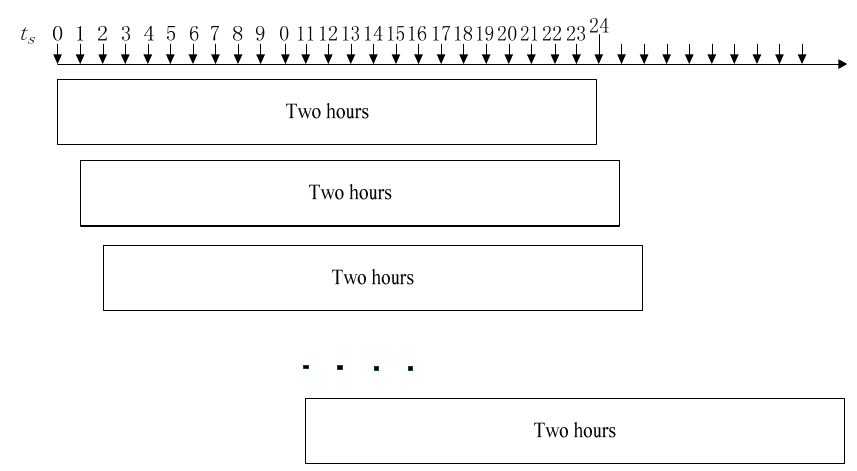
Figure 4. Single-level MPC performing rolling optimization (based on battery and fly